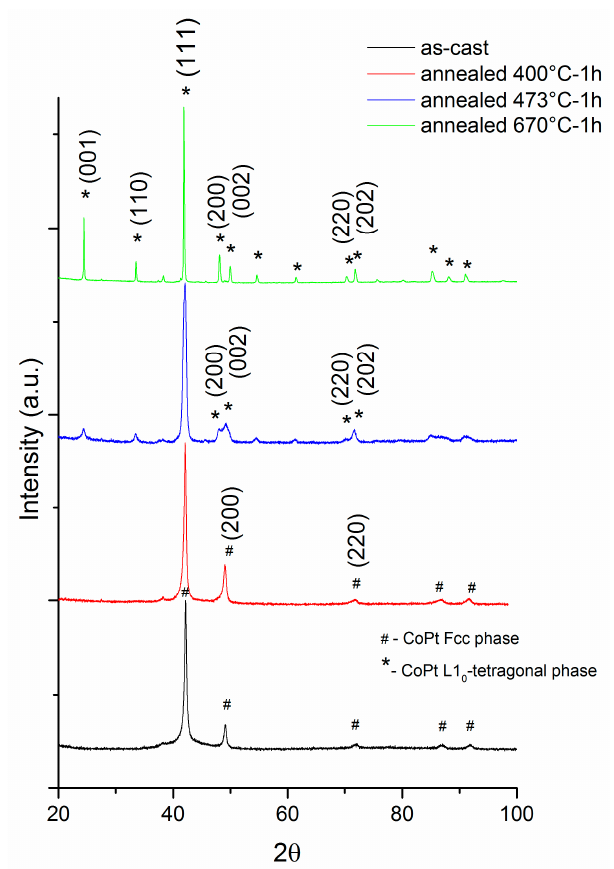
Figure 3. XRD patterns of all investigated samples, as-cast and annealed. The observed phases and reticular planes corresponding to main Bragg peaks are shown on the graph.